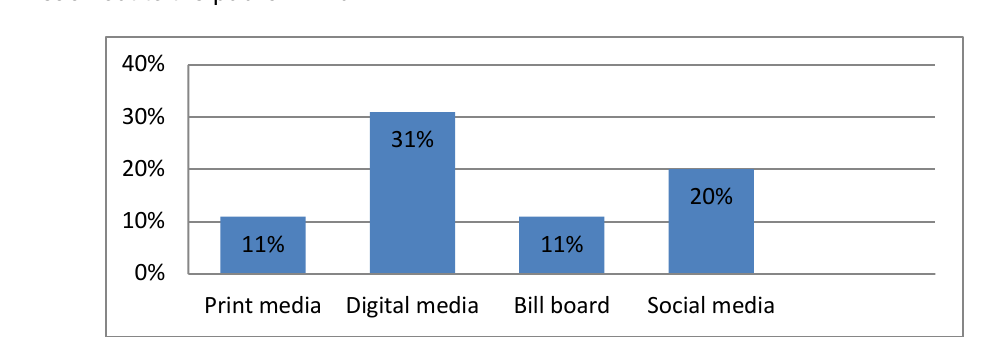
Figure 8 : the most effective way to promote the brand.